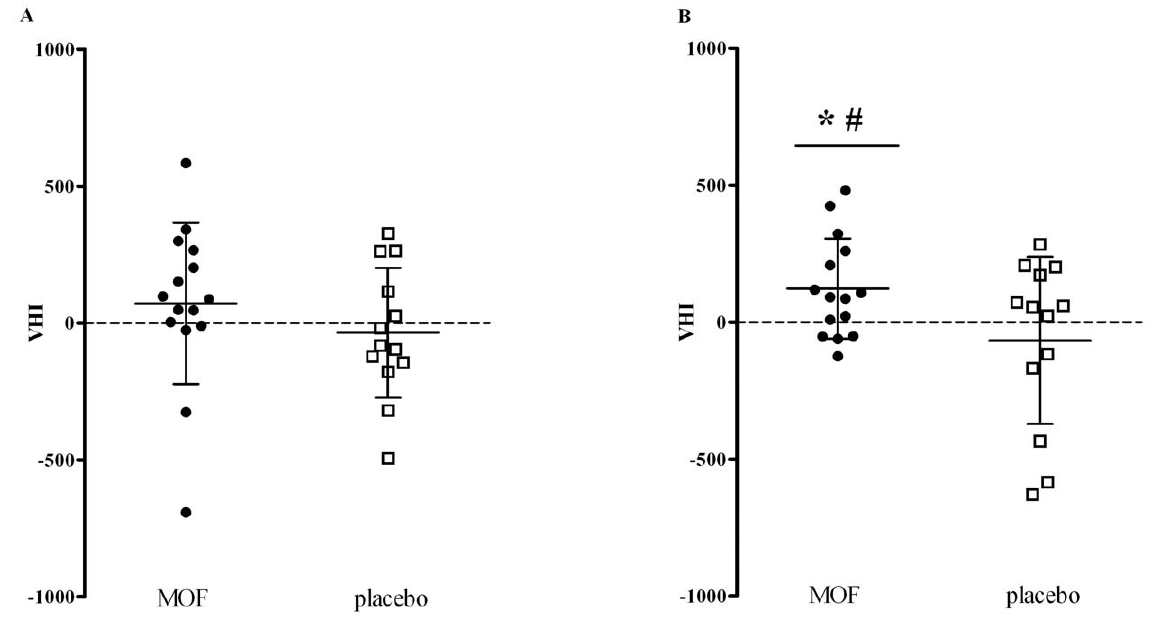
Figure 4. Mean ± SD vascular health index (VHI) of individual subjects after 4 (A) and 8 wk (B) supplementation with either 200 mg/d monomeric and oligomeric flavanols (MOF, n=15) or placebo (n=13). Within-group changes were appraised by one-tailed paired-samples t-test, between-group changes by two-tailed independent samples t-test; * Significantly different from baseline in the same group, P , 0.05. # Significant difference between groups at the same time, P ,